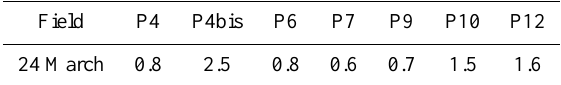
Table 3. Roughness Rms height (cm) measurements.